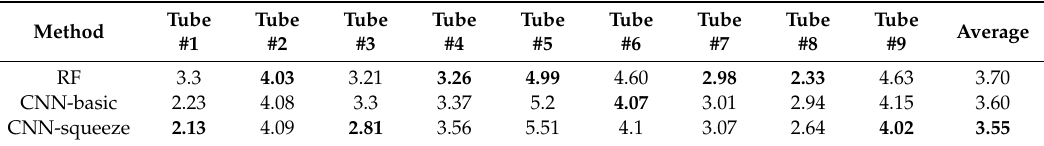
Table 3. Root mean square error (RMSE) of the remaining useful strength (RUS) values as evaluated by 9-fold cross-validation (CV).